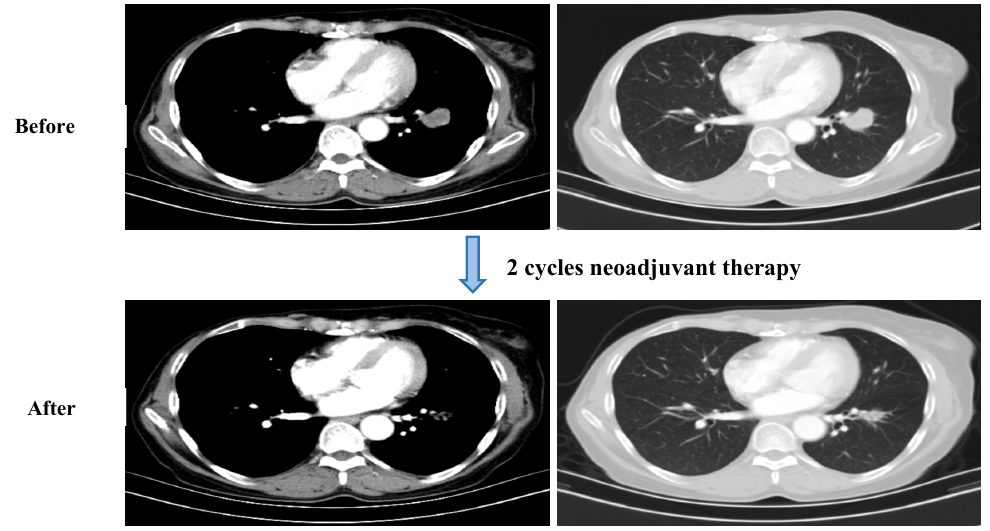
Figure 1. Computed tomography scan of the patient before and after neoadjuvant therapy showed the tumor significantly shrank.